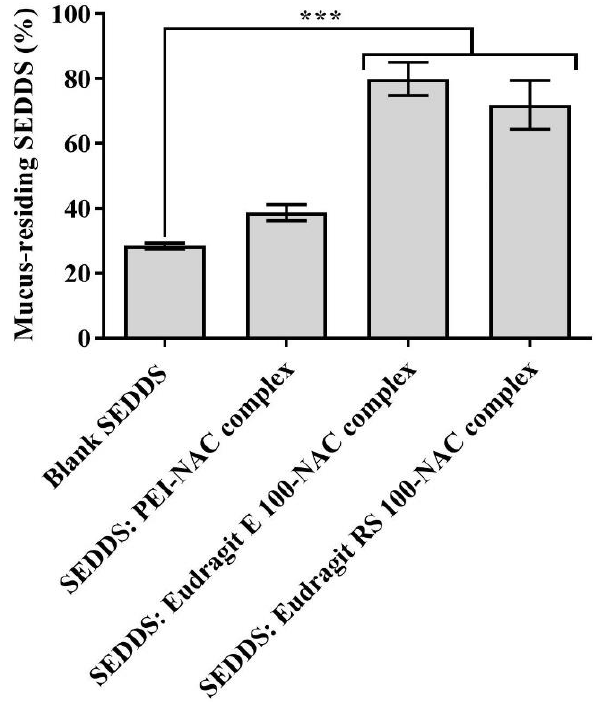
Figure 12. After 4 h of washing with 0.1 M phosphate buffer (pH 6.8) and incubation at 37 °C, the quantity of SEDDSs residing in porcine intestinal mucosal slices was measured using a 45° angle. *** p ≤ 0.001 versus a blank SEDDS. Indicated values are the means ± standard deviations ( n ≥ 3).